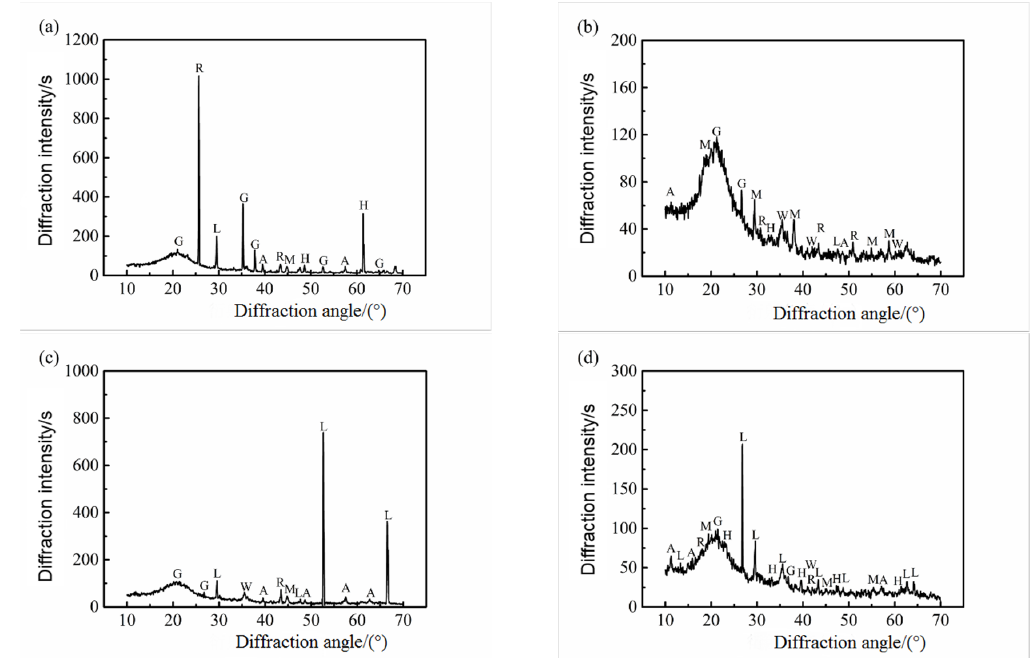
Figure 6. XRD patterns of rust sample of steel bar in ordinary concrete; ( a ) Inner rust layer of B1, ( b ) Outer rust layer of B1, ( c ) Inner rust layer of B2, ( d ) Outer rust layer of B2.